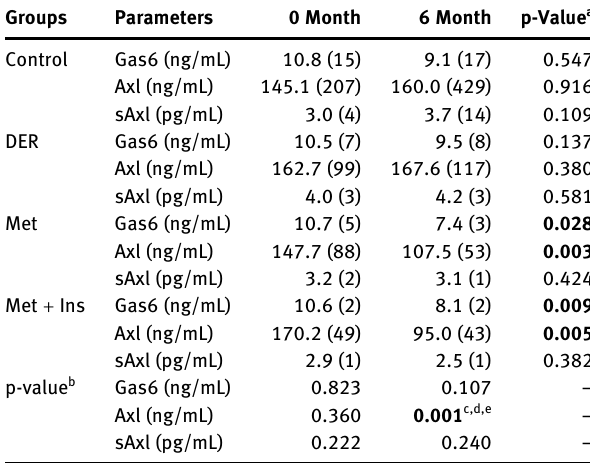
Table  : Comparison of Gas  , Axl,andsAxlparametersforBaseline and  th